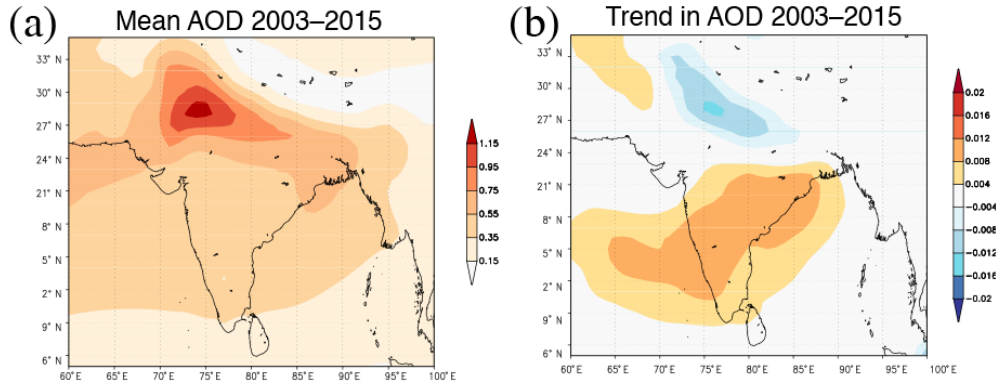
Figure 7. (a) Mean May–June aerosol optical depth at 550nm (AOD550) in the MACC reanalysis for 2003–2015. (b) Trend in AOD550 over this period (yr − 1